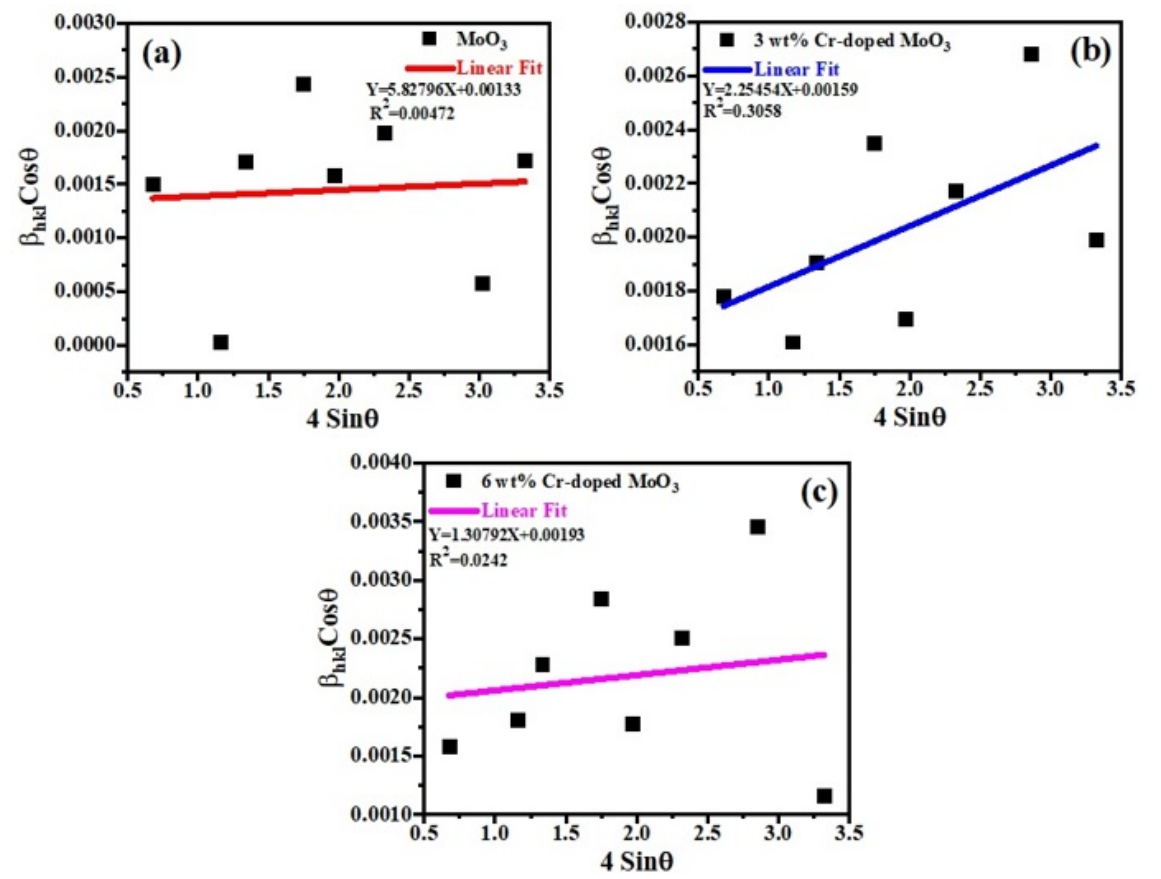
Figure 3. Williamson–Hall (W-H) plots of ( a ) un-doped, ( b ) 3 wt%, and ( c ) 6 wt% Cr-doped MoO 3. Table 1. Data on ( D W – H ) and ( ε W – H ) of un-doped and Cr-doped MoO 3 microrods along with